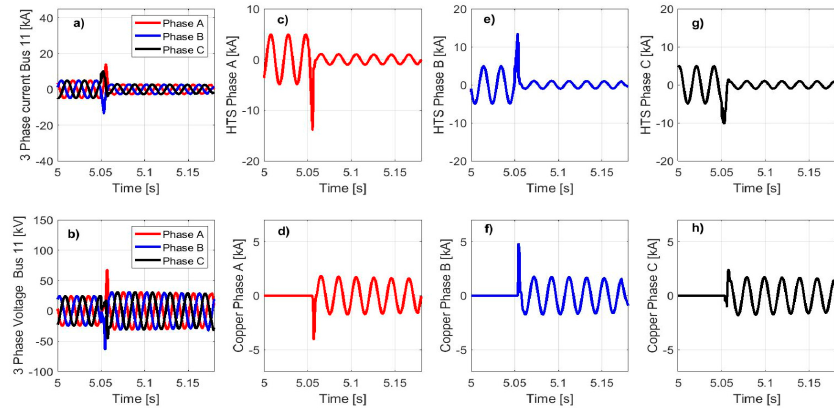
Figure 16. Fault current signatures for 3-Phase-to-ground fault at 50% of cable’s length: with R f 1 = 1 Ω ( a ) phase currents at Bus 11, ( b ) phase voltages at Bus 11, ( c ) current in HTS layer of phase A, ( d ) current in copper layer of phase A, ( e ) current in HTS layer of phase B, ( f ) current in copper layer of phase B, ( g ) current in HTS layer of phase C, ( h ) current in copper slayer of phase C.